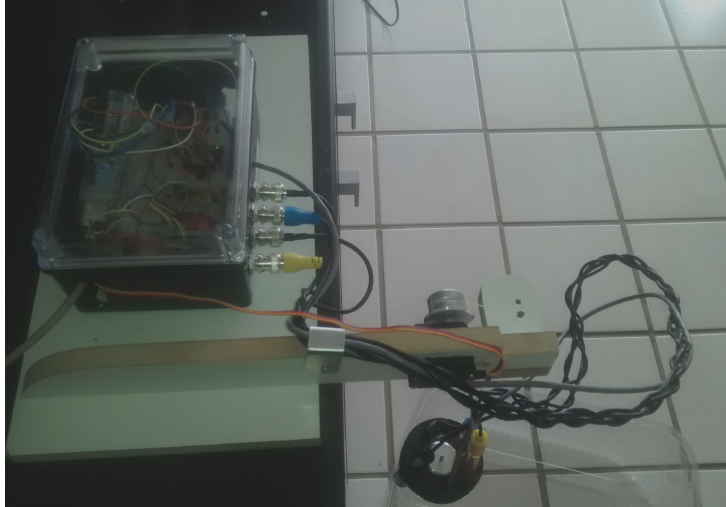
Figure 5. Physical system prototype, in the botton it can be seen a piece of wood with a spool (attached to a servomotor) where it runs the thread that put the sensors in and out of the water; the electronic circuit prototyped in a board can be seen in the top left box (will be seen in detail in Figure 6); the sensors are (waterproof) coupled at the end of the braided cables seen in the right